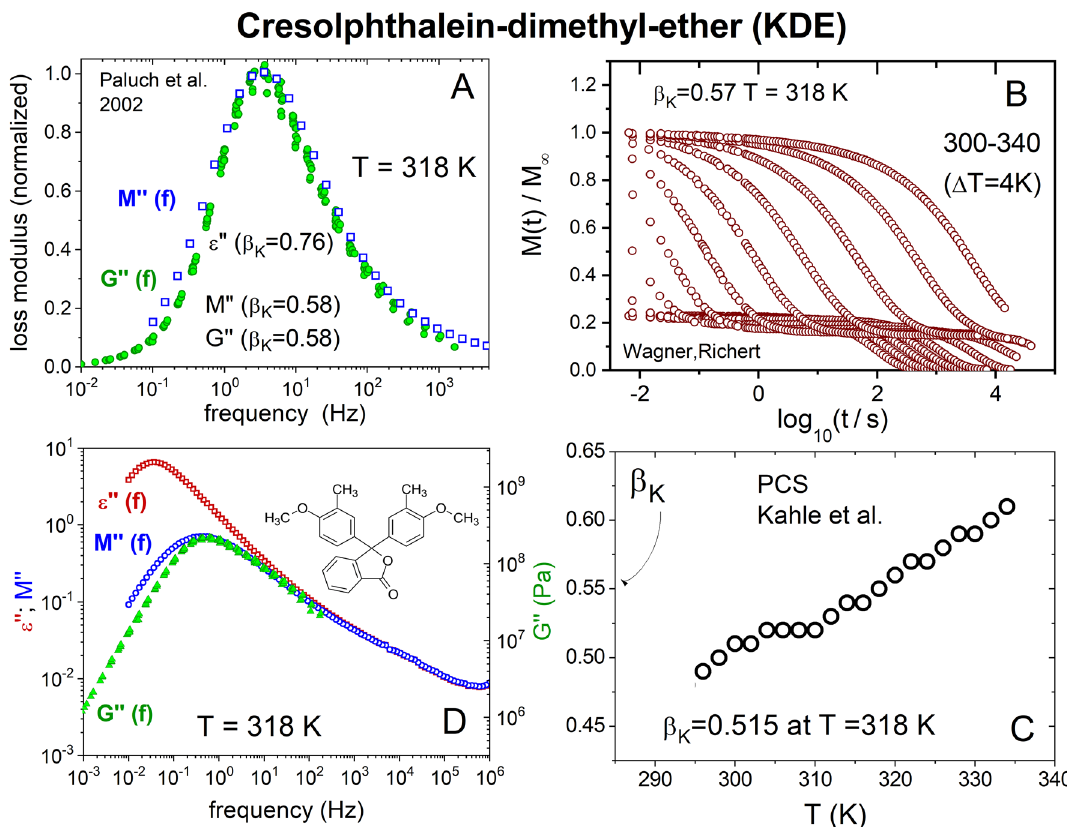
Figure 1. Collection of data of cresolphthaleine-dimethyl-ether (KDE). ( A ) Shows the frequency dispersions of M ″ ( f ) and the scaled G ″ ( f ) are nearly the same and broader than that found in ε ″ ( f ), and explains why the Kohlrausch exponents β M K = 0.58 and β G K = 0.58 are smaller than β DS K = 0.76. ( B ) Shows the M ( t ) data of KDE from Richert and Wagner 38 having time dependence well described by the Kohlrausch function with β M K = 0.57. ( C ) Shows the exponents β PCS K ( T ) of the light scattering intensity autocorrelation functions from Kahle et al. 40 and assume the value of β PCS K = 0.51 at 318 K. ( D ) Shows the ε ″ ( f ), and the vertically shifted data of M ″ ( f ), and scaled G ″ ( f ) data of KDE at 318 K from Ref. 39 showing the large strength of the α-relaxation in ε ″ ( f ) is significantly reduced in M ″ ( f